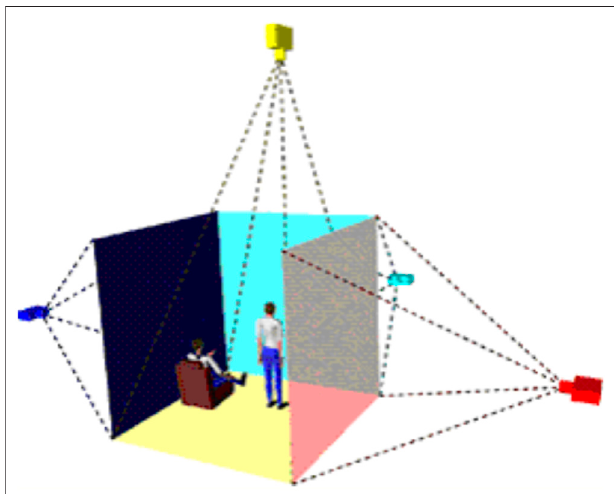
FIGURE 2 | An example of the cave automatic virtual environment (CAVE). Image courtesy of Wilkerson et al. (2008).